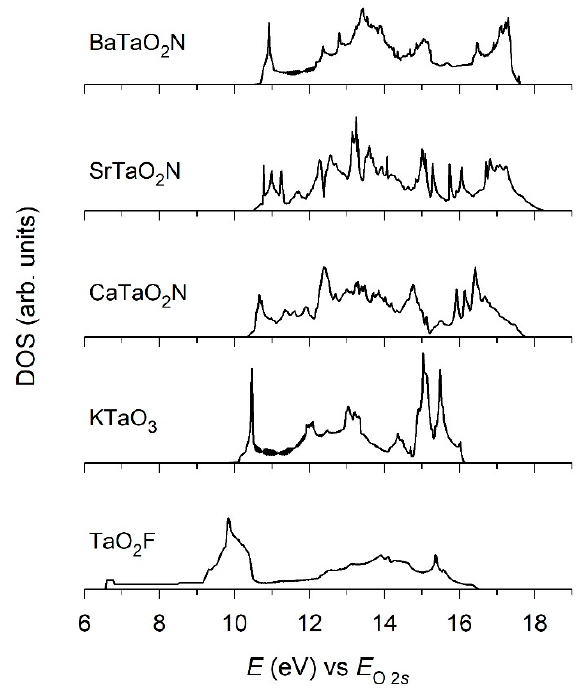
Figure 2. Valence band density of states (DOS) structures for BaTaO 2 N, SrTaO 2 N, CaTaO 2 N, KTaO 3 , and TaO 2 F as calculated using the CAmbridge Serial Total Energy Package (CASTEP) code.